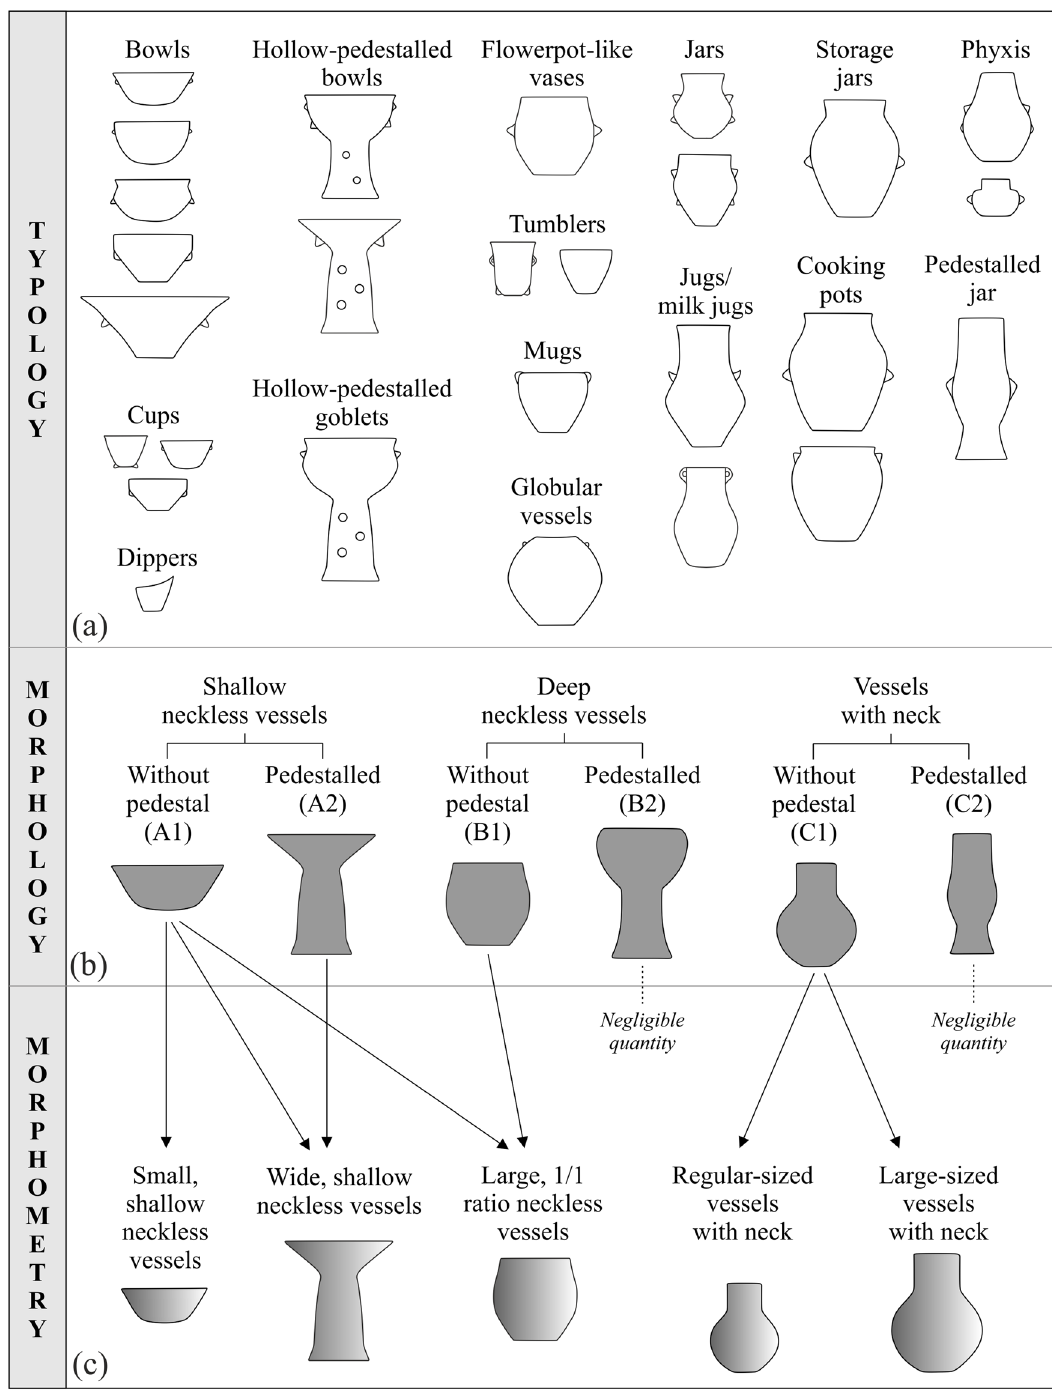
Figure 2: Categorisation of the Early Copper Age vessels: ( a ) typological categories; ( b ) morphometrical categories ( with sematic images using simpli fi ed geometric forms ) ; and ( c ) morphologic categories ( with sematic images using simpli fi ed geometric forms )